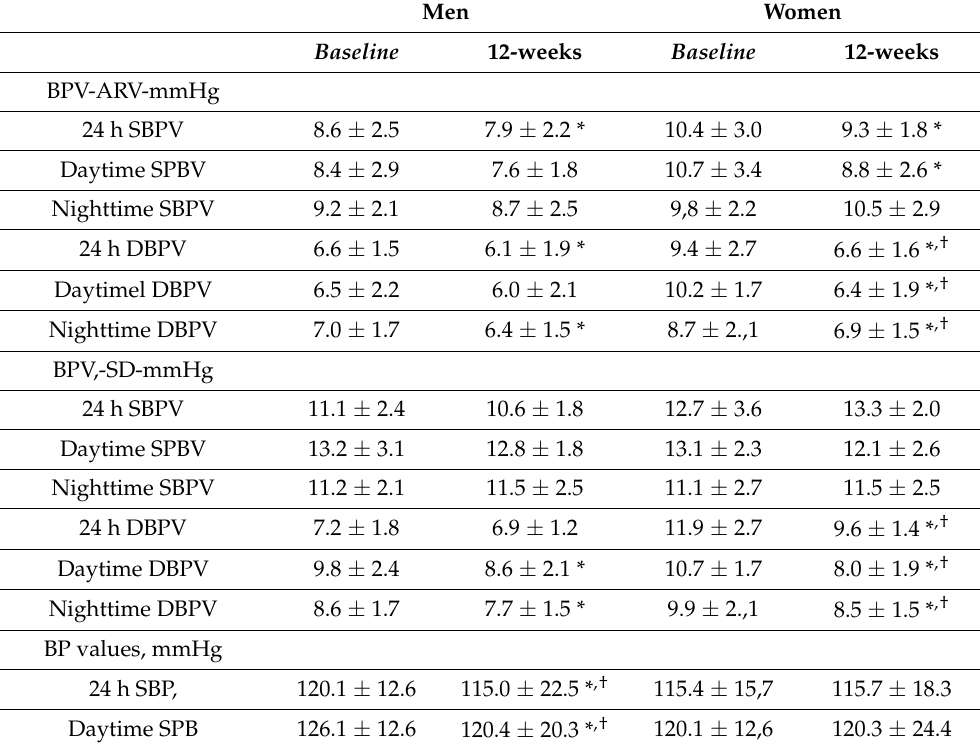
channel antagonists. Table 2. Changes in blood pressure variability, blood pressure values, and heart rate in males and